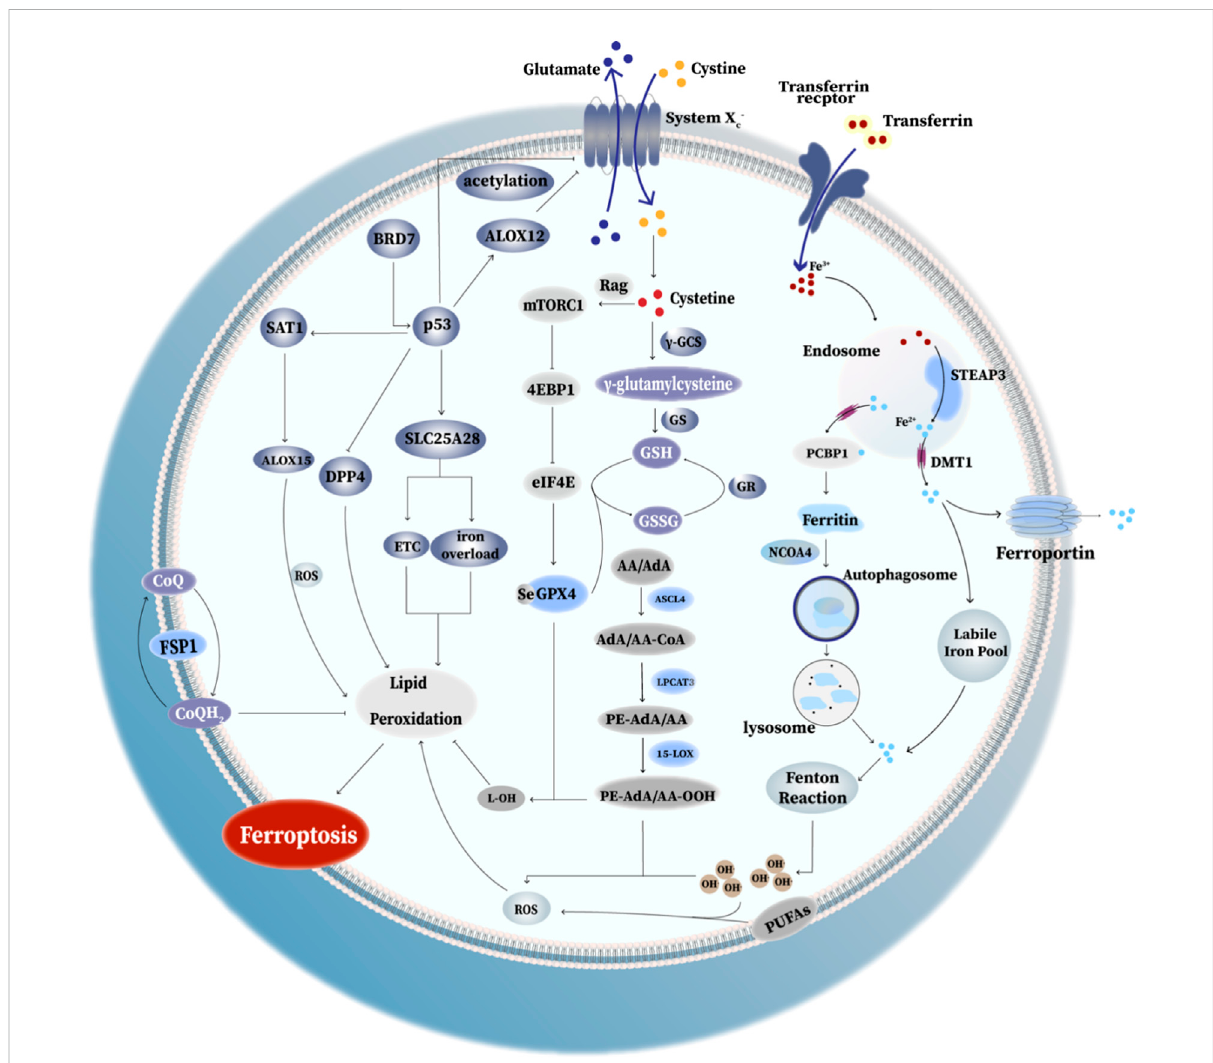
FIGURE 2 Mechanism of ferroptosis. I. Ferritinophagy-related ferroptosis: the degradation of ferritin via autophagy causes the iron dysregulation, which can lead to iron overload and trigger ferroptosis. II. GPX4 anti-ferroptosis way: GPX4 converts toxic lipid hydroperoxides to non-toxic lipid alcohols. SystemX c − exchangescystineandglutamateinaratioof1:1.CystineentersthecellandconvertstocysteineforthesynthesisofGSH,thuspromoting GPX4proteinsynthesis andenhancingitsantioxidantfunction. III.Rag-mTORC1-4EBPsignaling axis:mammalian target ofrapamycincomplex 1 (mTORC1) and promotes GPX4 protein synthesis at least partly through the Rag-mTORC1-4EBP signaling axis. (Rag(Ras-related GTPase): Rag GTPases play important roles in mTORC1 activation in response to amino-acid stimulation; eIF4E: eukaryotic initiate factor 4E; 4EBP(eIF4E binding protein): binding to eIF4E and thus decreased GPX4 level. IV. p53-mediated ferroptosis: (1) acetylation of p53 is crucial for p53-induced ferroptosis; (2) SAT1 activated by p53 induces ferroptosis via promoting ALOX15 expression;(3) the elevated BRD7 expression promote p53 mitochondrial translocation,leadingtotheinteractionbetweenmitochondrialp53andSLC25A28, whichcouldleadtotheabnormalaccumulationofredox-active iron and hyperfunction of electron transfer chain (ETC). (4) p53 promote ALOX12 binding with SLC7A11, eventually causing the inhibition of SystemX c − and triggering ferroptosis. (5) p53 inhibit erastin-induced ferroptosis via blocking the activity of DPP4. V. FSP1: FSP1 locates in the plasma membranewhereitfunctionsasanoxidoreductasethatreducescoenzymeQ 10 (CoQ).ReducedCoQactsasalipophilicradical-trappingantioxidant that halts the propagation of lipid peroxides, thus inhibiting ferroptosis. VI. PE-OOH as a ferroptotic death signal: ferroptosis involves a highly organized oxygenation center, wherein oxidation in endoplasmic-reticulum-associated compartments occurs on only one class of phospholipids (phosphatidyletha-nolamines(PEs))andisspeci fi ctowardtwofattyacyls — arachidonoyl(AA)andadrenoyl(AdA).Moreover,severalkeyenzymeslike ASCL4, LPCAT3 and 15-LOX play a key role in proferroptotic